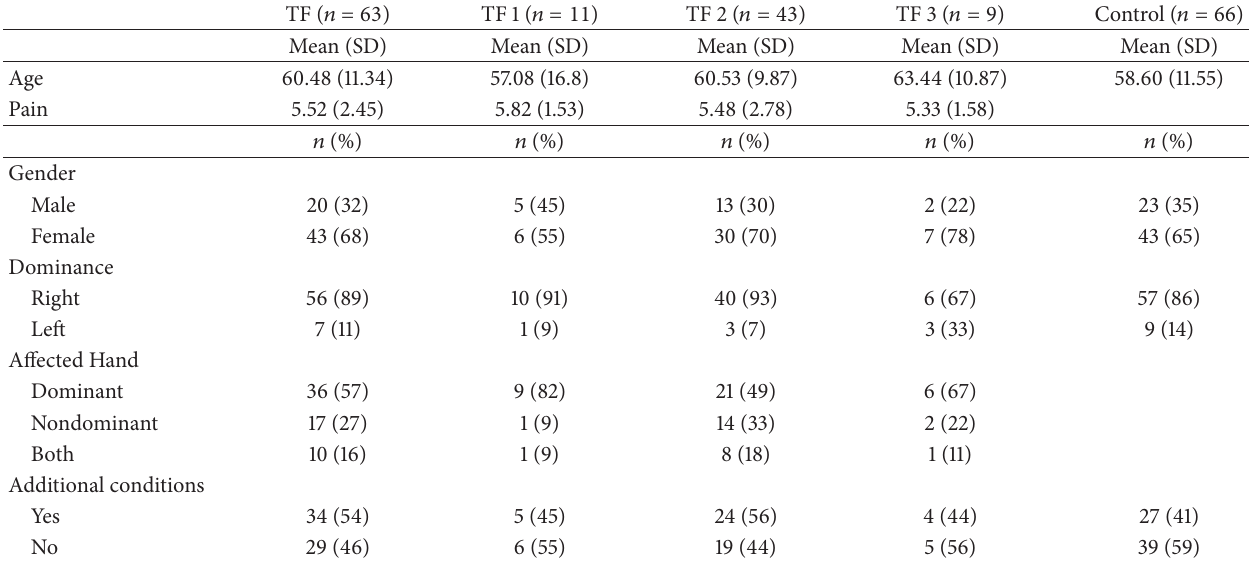
Table 1: Demographic and clinical data: comparison of TF subgroups.